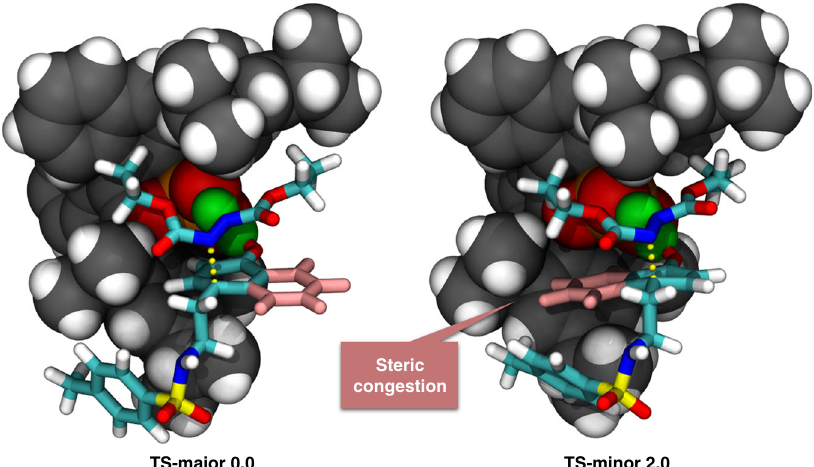
Fig. 5 Transition states. Optimized structures and relative Gibbs free energies (in kcal/mol) of the transition states of the aminative dearomatization step ( ω B97XD/def2-TZVPP//B97D/6-31G**). The catalysts are presented with the van der Waals model. The substrates are presented with the stick model. The forming C – C bonds are shown in yellow dash lines. The transferring protons are shown in green spheres. The intact benzene rings of α -naphthols are shown in pink